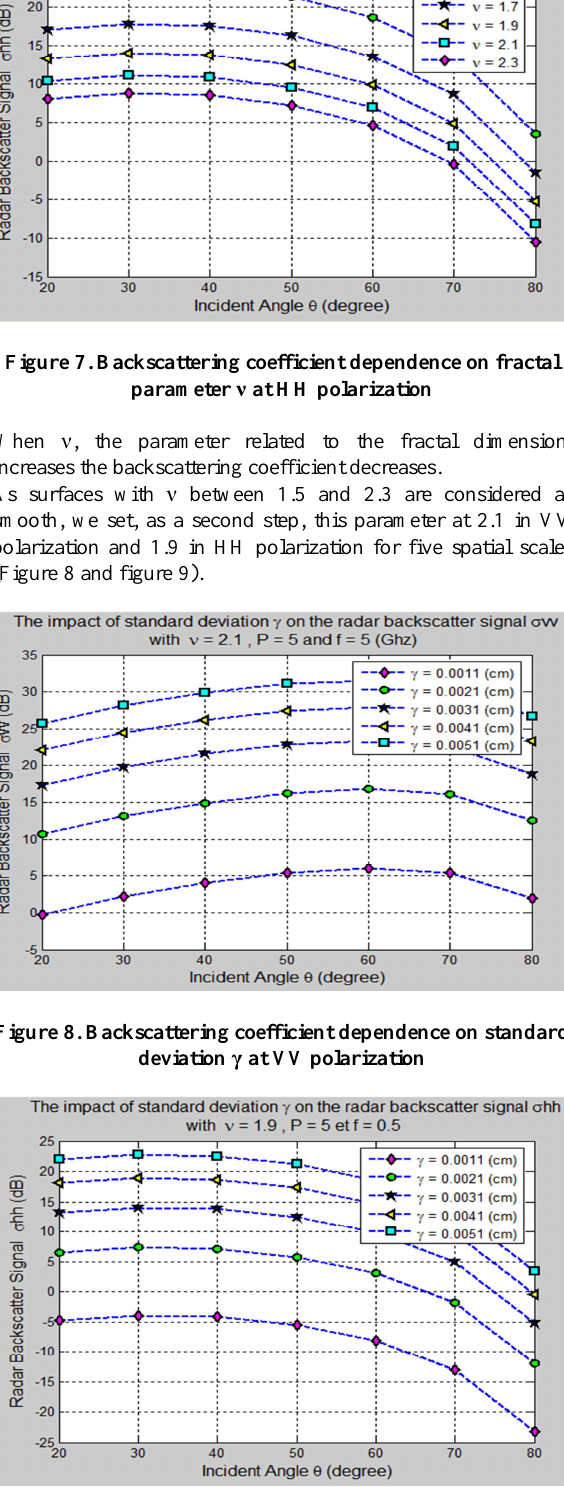
Figure 9. Backscattering coefficient dependence on standard deviation γ at HH